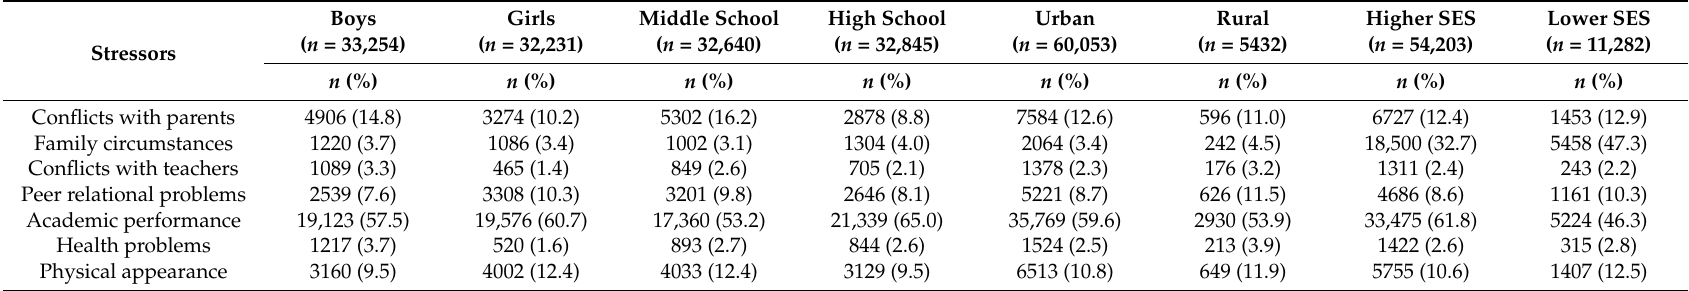
Table 2. Distribution of major stressors among Korean adolescents according to gender, educational level, residential area, and socioeconomic status level.